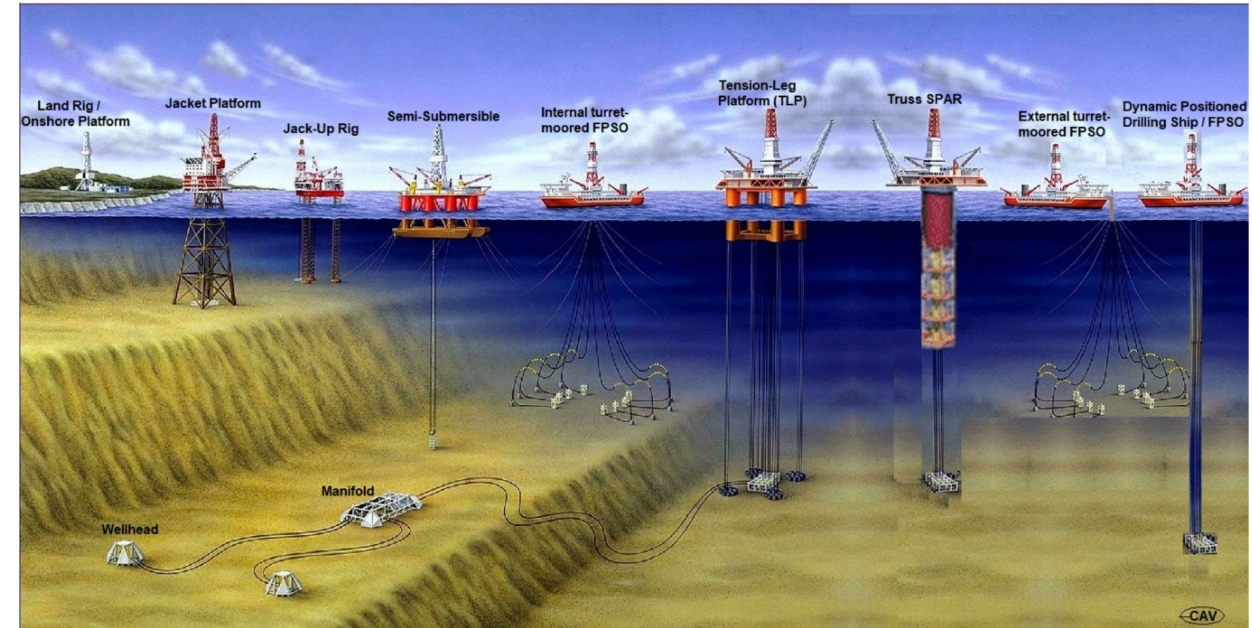
Figure 1. Different types of deep-water offshore facilities for drilling and production, showing land rig/onshore platform {10–100 m}, conventional fixed platforms{150–412 m}, jacket platform {150–412 m}, semisubmersibles {457–1920 m}; floating production, storage and offloading (FPSO) unit {1345–1500 m}; tension leg platform (TLP) {457–2134 m}; Truss SPAR {610–3048 m}; subsea wellhead, completion and tieback to a host facility, and subsea